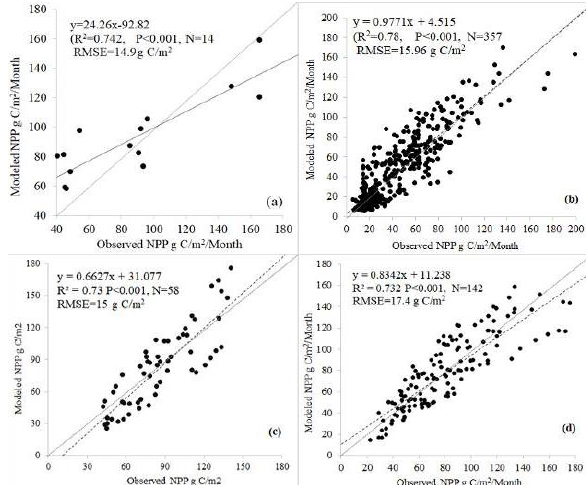
Figure 3. Comparisons between the modeled and field observed net primary productivity., a) 2007, b) 2009 с) 2014 d) 2015 Figure 2. Spatial distributions of 34-year average growing season NPP